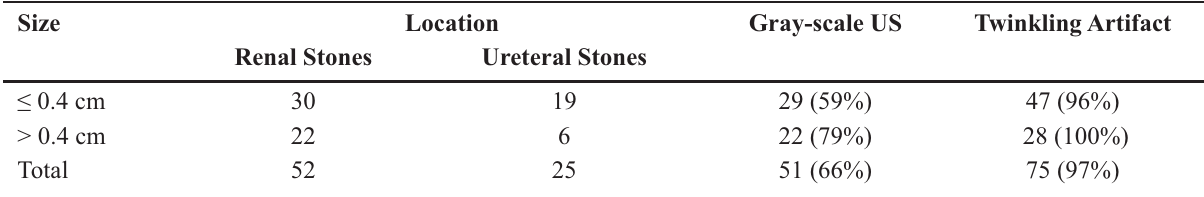
Table 1 – Comparison of gray-scale ultrasound (US) and Doppler twinkling artifacts of urinary stones based on stone location and stone